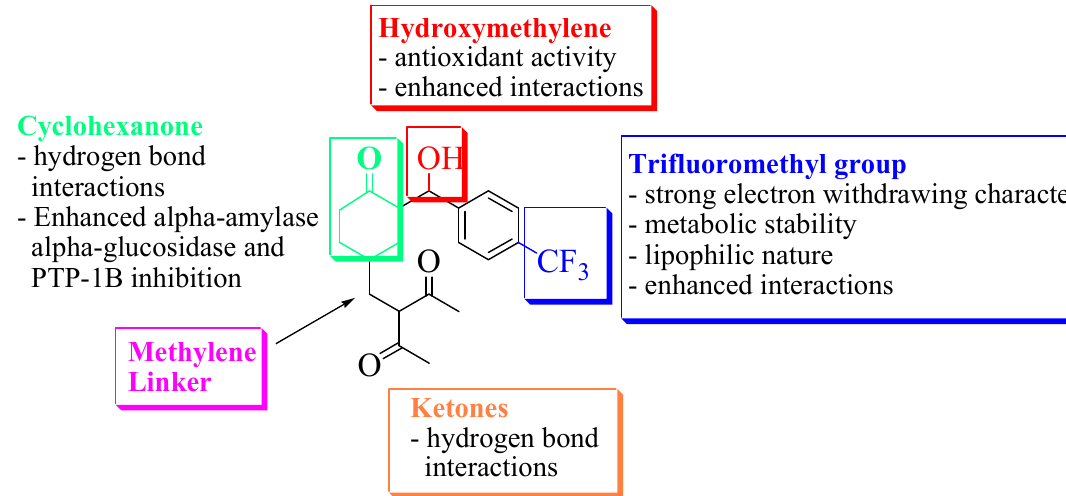
Figure 1. Design rational for current research.